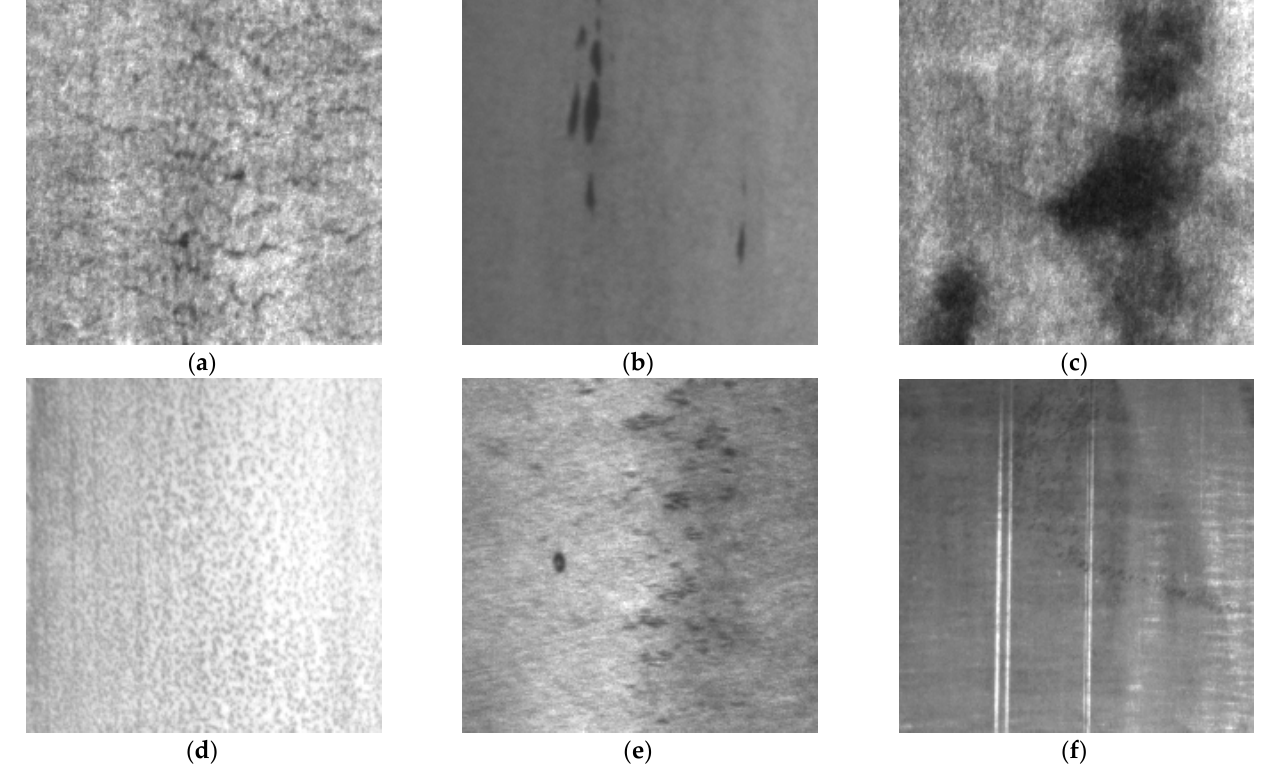
Figure 4. Categories of defects: ( a ) Cr, ( b ) In, ( c ) PA, ( d ) PS, ( e ) RS, ( f ) Sc.